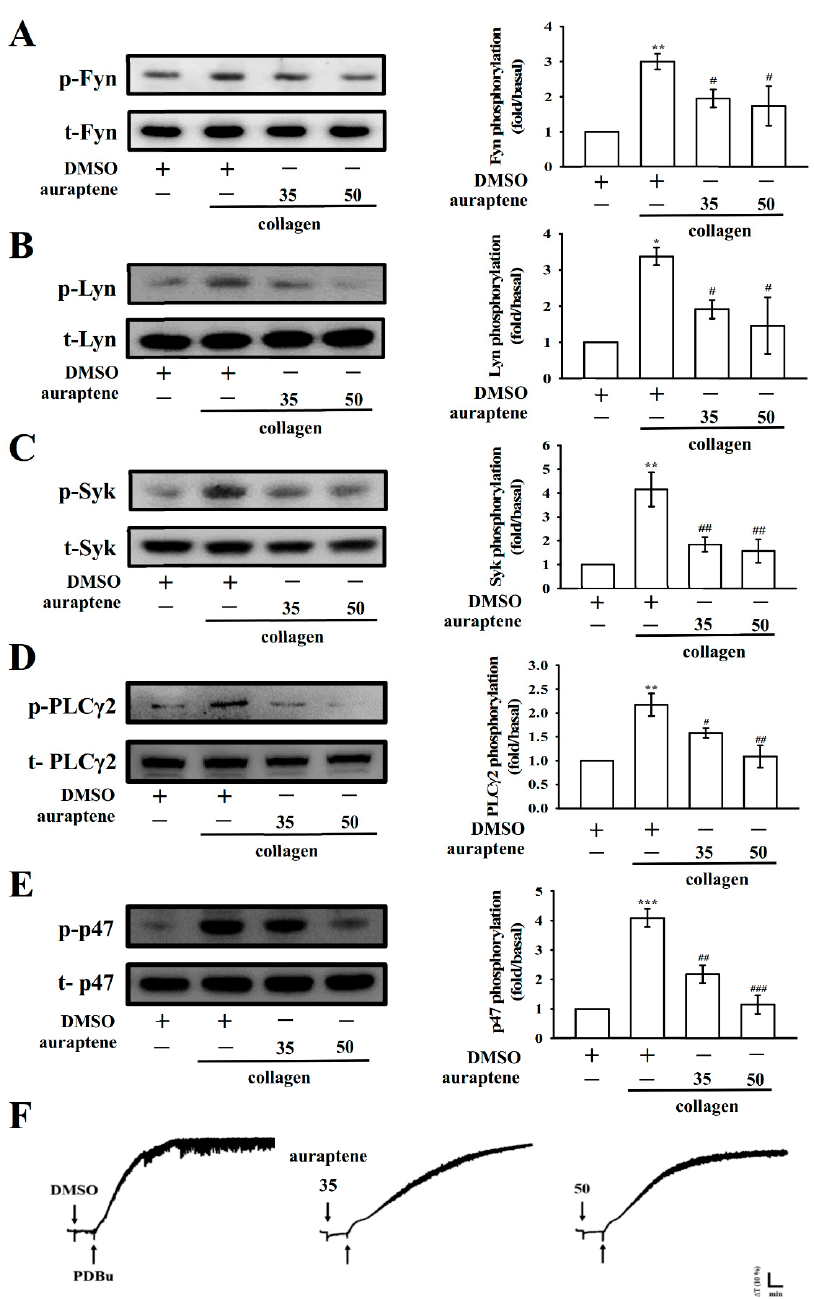
Figure 4. Regulatory e ff ects of auraptene on Fyn, Lyn, Syk, and PLC γ 2 / PKC phosphorylation in platelets. Washed platelets were preincubated with 0.1% DMSO or auraptene (35 and 50 µ M) and then treated with collagen (1 µ g / mL) or PDBu (150 nM) to trigger either ( A ) Fyn, ( B ) Lyn, ( C ) Syk, ( D ) PLC γ 2, ( E ) PKC activation (p-p47), or ( F ) platelet aggregation. Data are given as mean ± SEM ( n = 4). * p < 0.05, ** p < 0.01, and *** p < 0.001, compared with the resting platelets; # p < 0.05, ## p < 0.01, and ### p < 0.001, compared with the DMSO-treated group. Profiles in ( F ) are illustrative of three independent